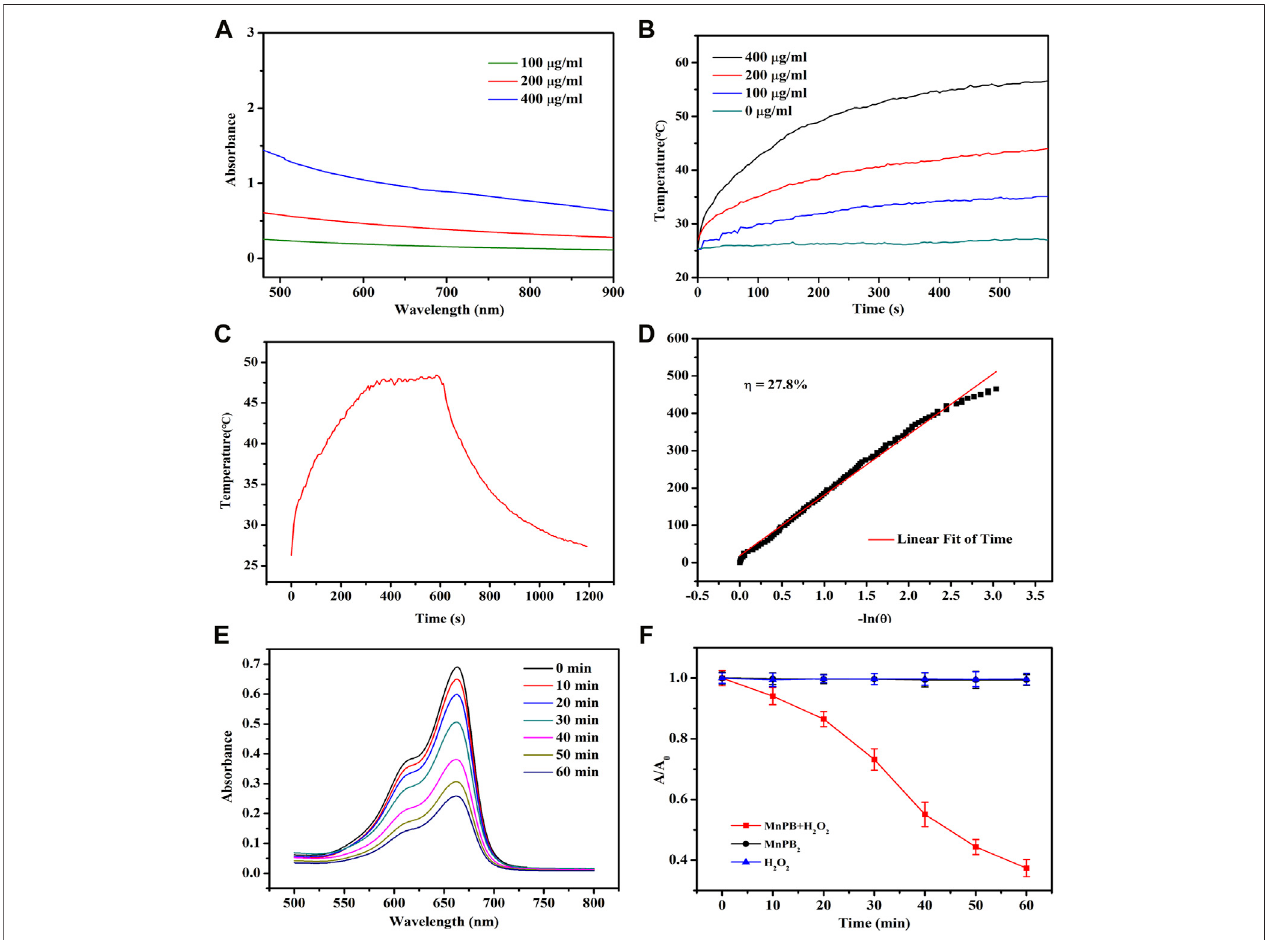
FIGURE 2 | The photothermal properties of MnPB NPs. (A) UV − vis − NIR absorption spectra of MnPB NPs at varying concentrations. (B) Temperature pro fi les of MnPB NPs at various concentrations under NIR laser irradiation (808 nm, 1.0 W/cm 2 ). (C) The heating-cooling curve of MnPB NPs at 200 μ g/ml under NIR laser irradiation (808 nm, 1.0 W/cm 2 ). (D) Red linear regression curve for natural cooling process. (E) Degradation of MB treated with MnPB NPs and H 2 O 2 versus time. (F) Absorbance of MB at 664 nm in different groups.